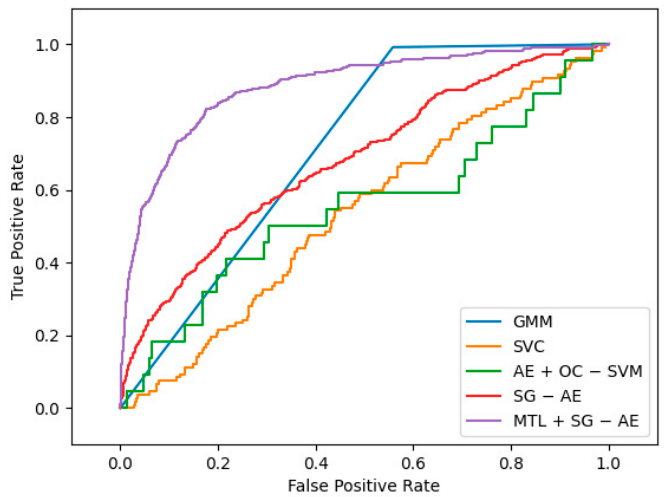
Figure 9. The best ROC curves of five algorithms.